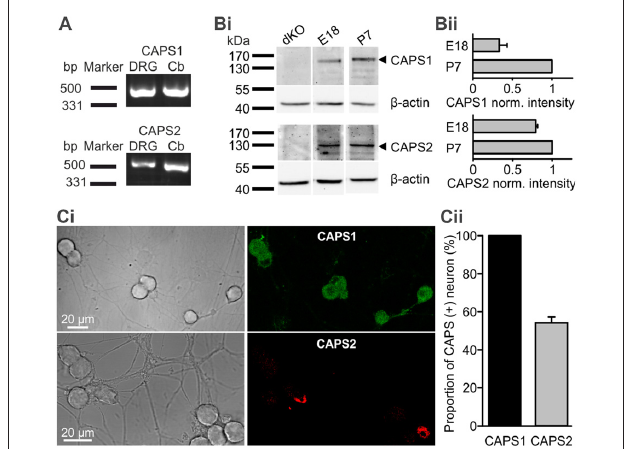
DRG neurons in culture with anti-CAPS1 (top) and anti-CAPS2 (bottom) antibody suggests that CAPS1 is present in all DRG neurons while CAPS2 is present in a subpopulation of DRG neurons. The specificity of the antibodies was verified ( Supplementary Figure S5 ). (Cii) Quantification of CAPS paralog expression among DRG neurons ( N mice = 5, n neuron = 70 and 191 for CAPS1 and CAPS2,